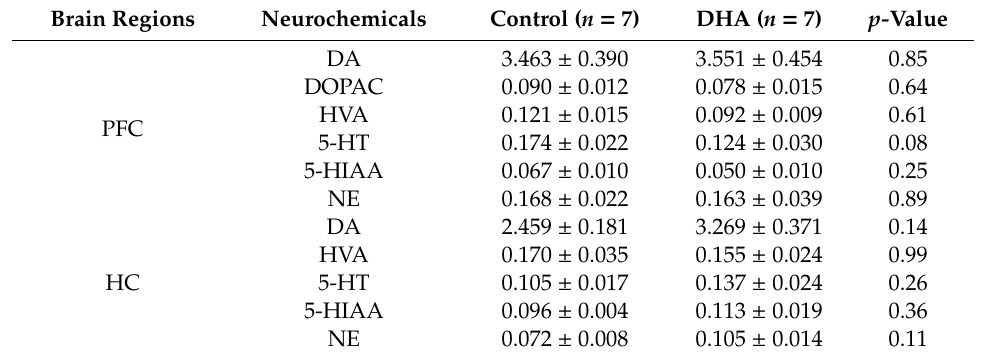
Table 6. Concentrations of monoamines and their metabolites in the PFC and HC in piglets at weaning. Brain Regions